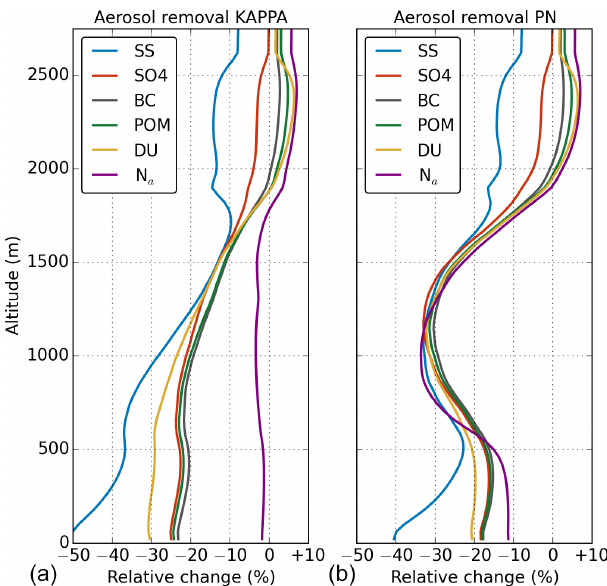
Figure 5. Vertical profile of domain-averaged aerosol mass and number concentration after 6h for the KAPPA (a) and PN (b) sim- ulations relative to the initial